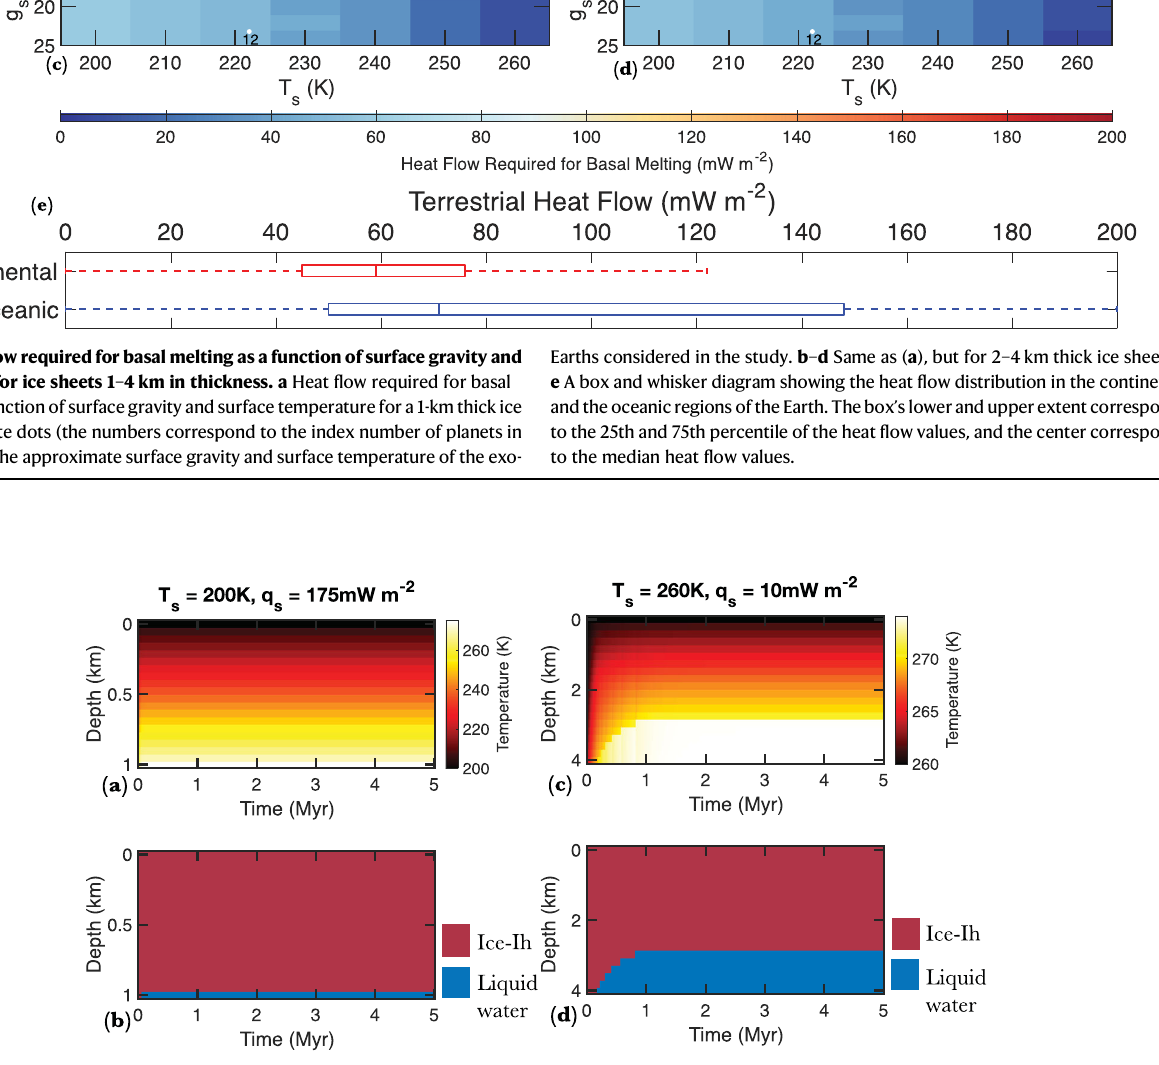
TRAPPIST 1g over a 5-million-year time frame. c Temperature distribution as a function of depth and time on Kepler 442 b for a 4km thick ice sheet, T s of 260K, and heat fl ow of 10mWm − 2 . d Ice phase evolution as a function of depth and time on Kepler 442 b over a 5-million-year time frame.